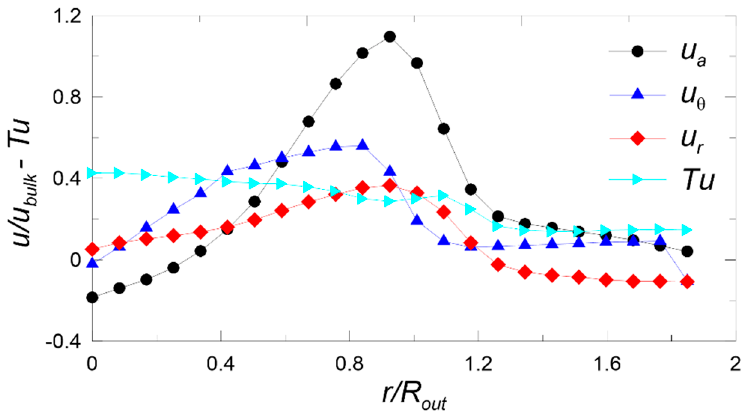
Figure 3. Radial distributions (traverse at x / R out = 0.67) of axial, radial, and tangential velocity components.